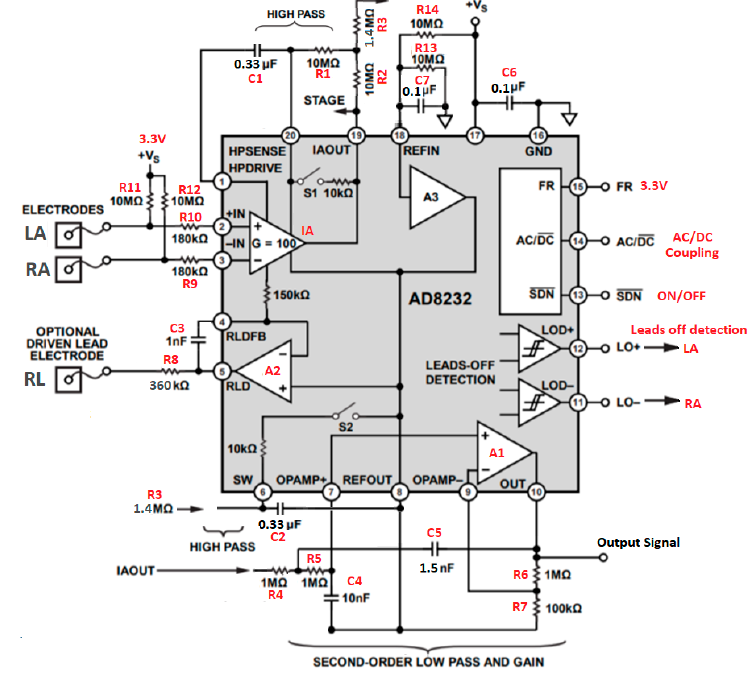
Figure 2. Analog Device’s AD8232 simplified internal structure and the cardiac monitor configuration. LA, RA, and RL correspond to the electrodes; R11 and R12 to polarization resistors; R10 and R9 to resistors to protect the user in case of failure; R8 and C3 are protection to limit leakage currents < 10 uA; R4, R5, R6, R7, C4, and C5 represent the section of resistors and capacitors for low- pass filter; R6 and R7 represent resistors that determine the total gain of the circuit; C1, C2, R1, and R2 are resistors and capacitors that define the cutoff frequency of the high-pass filter; R3 (or Rcomp) for the filter response curve; R13 and R14 are voltage divider resistors for the midsupply reference; and C6 and C7 are noise filters. The image was modified from the source [24].